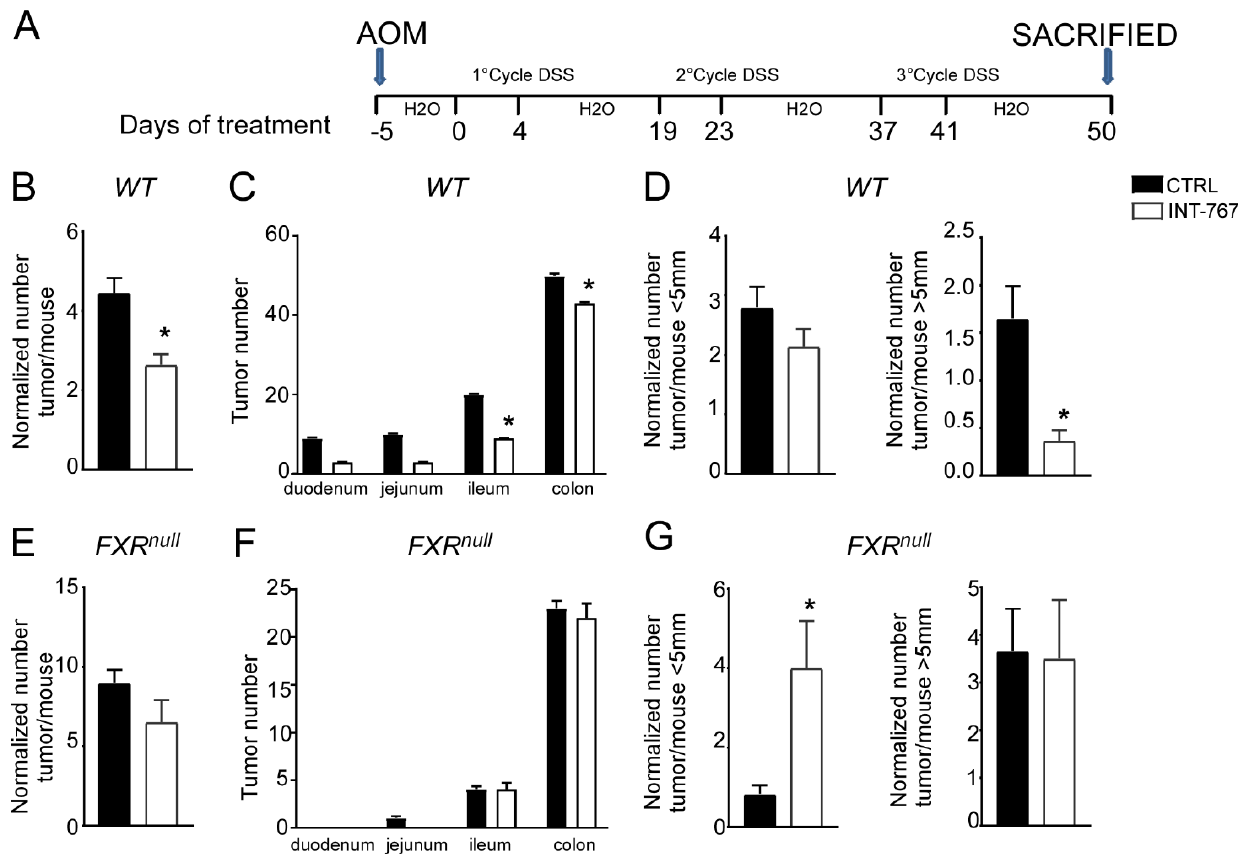
Figure 4. INT-767 protects WT mice from AOM/DSS-induced colorectal cancer. ( A ) Schematic representation of AOM/DSS administration. AOM (12 mg/Kg) is injected on day 0. 5 days later, DSS solution is administered to mice in drinking water. 5 days of DSS treatment is followed by 16 days of drinking water. This cycle was repeated a total of 3 times. ( B ) Total number of tumors was counted in WT mice fed with or without INT-767 diet. The diameter of each tumor was measured ( n = 7 WT CTRL and n = 7 WT INT-767). ( C ) The entire length of the intestine was analyzed for tumor formation ( n = 7 WT CTRL and n = 7 WT INT-767). ( D ) Normalized number of tumors <5 mm and >5 mm per mouse from intestine of WT mice fed with or without IN-767 ( n = 7 WT CTRL and n = 7 WT INT-767). ( E ) Total number of tumors was counted in Fxr null mice fed with or without INT-767 diet. The diameter of each tumor was measured ( n = 7 Fxr null CTRL and n = 7 Fxr null INT-767). ( F ) The entire length of the intestine was analyzed for tumor formation ( n = 7 Fxr null CTRL and n = 7 Fxr null INT-767). ( G ) Normalized number of tumors <5 mm and >5 mm per mouse from intestine of Fxr null mice fed with or without IN-767 ( n = 7 Fxr null CTRL and n = 7 Fxr null INT-767). All results are the mean ± SEM. Statistical significance was assessed by Student’s t -test (* p < 0.05).